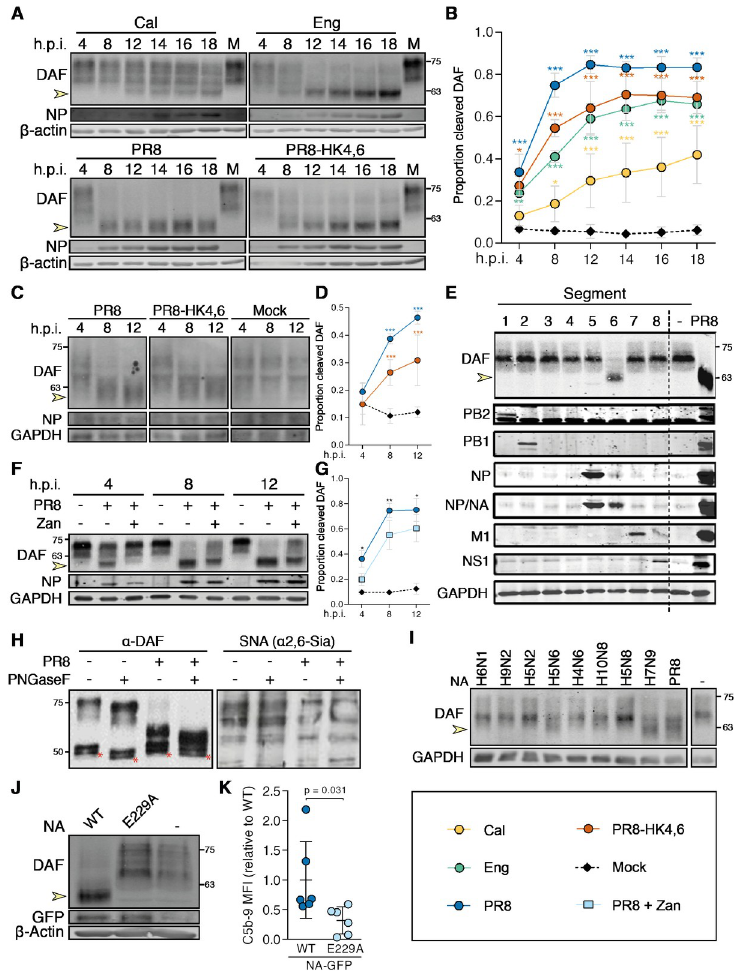
Fig 10. Influenza A virus neuraminidase cleaves DAF through its sialidase activity. A: Western blot detection of complement decay-accelerating factor (DAF) in A549 cells upon infection with A/California/7/2009 (Cal), A/England/ 195/2009 (Eng), A/Puerto Rico/8/1934 (PR8) or A/X-31 (PR8-HK4,6) at a multiplicity of infection (MOI) of 5. B: The proportion of cleaved DAF was measured in each lane as the ratio of low molecular weight (MW) to total DAF pixel densitometry. C: Western blot detection of DAF in mouse embryonic fibroblasts (MEFs) derived from C57/BL6 WT or Daf -/- mice upon infection with PR8 or PR8-HK4,6 at a MOI of 5. D: The proportion of cleaved DAF was measured in each lane as the ratio of low MW to total DAF pixel densitometry. ( B , D : data shown as mean ± sd, from three independent experiments). E: Western blot detection of DAF in HEK293T cells after transfection with plasmids encoding the eight different PR8 viral segments. F: Western blot detection of DAF in A549 cells upon infection with PR8 at a MOI of 5, treated with Zanamivir. G: The proportion of cleaved DAF was measured in each lane as the ratio of low MW to total DAF pixel densitometry (data shown as mean ± sd, from four independent experiments). H: DAF was purified by immunoprecipitation from cell lysates of A549 cells infected with PR8 at 12 hours post-infection (h.p. i.), treated with PNGaseF and analyzed by western blot or lectin blot with Sambucus nigra agglutinin (SNA) ( � indicates IgGs from immunoprecipitation). Results are representative of three independent experiments. I: Western blot detection of DAF in HEK293T cells after transfection with plasmids encoding NAs from the indicated avian IAVs: H6N1 A/chicken/Taiwan/67/2013, H9N2 A/chicken/Pakistan/UDL-01/08, H5N2 A/goose/Taiwan/01031/2015, H5N6 A/chicken/Jiangxi/02.05 YGYXG023-P/2015, H4N6 A/chicken/Hunan/S1267/2010, H10N8 A/chicken/Jiangxi/1204/ 2014, H5N8 A/scarlet ibis/Germany/Ar44-L01279/2015, H7N9 A/Anhui/1/2013. J: Western blot detection of DAF in HEK293T cells transfected with eight plasmids encoding each of the PR8 segments, including wild-type NA (WT) or the catalytically-impaired mutant NA-E229A (E229A). K: Flow cytometry detection of C5b-9 deposition in A549 cells after transduction with WT or catalytically-impaired mutant NA-E229A and treatment with serum (data shown as mean ± sd, from six independent experiments, each corresponding to a pool of five independent transductions. Each point represents the median fluorescence intensity (MFI) of a sample treated with serum minus its corresponding heat-inactivated control.). Yellow arrows indicate cleaved DAF. MW is indicated in kDa. Statistical analysis detailed in materials and